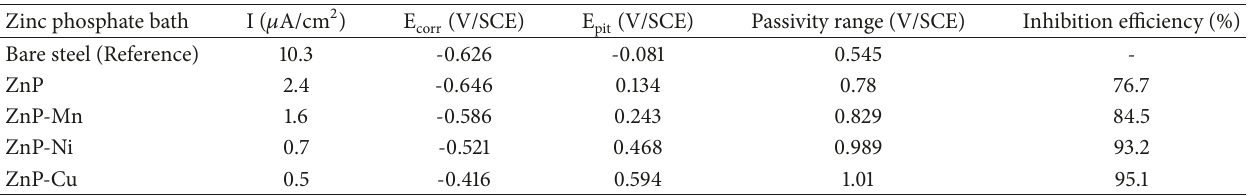
Table 6: I corr , E corr , E pit , the passivity range, and the inhibition efficiency for the coated steel specimens and the bare steel.